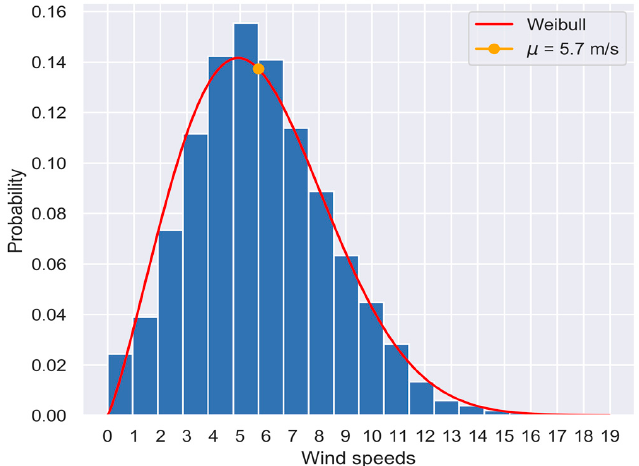
Figure 3. Histogram (in blue) and Weibull probabilistic model (red line) for the wind speeds recorded. The orange dot represents the first moment of the distribution 𝜇 of 5.7 m/s. Mode wind speeds are located between 5 and 6 m/s.